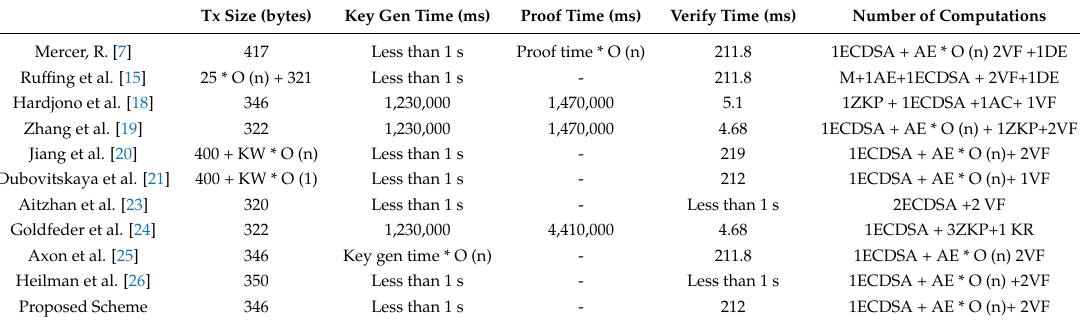
Table 7. A comparison of the efficiencies of schemes for privacy in blockchain.